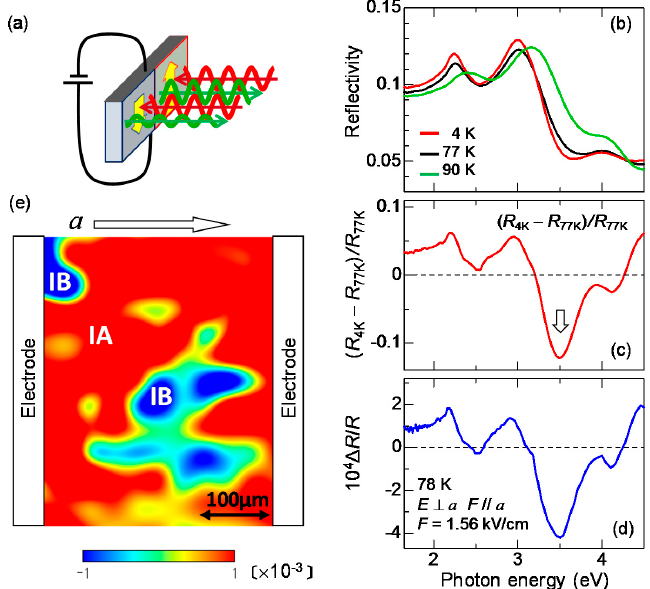
Figure 7. Polarization-domain imaging by electro-reflectance (ER) spectroscopy in TTF-CA [61]. ( a ) Schematic of a polarization-domain imaging method; ( b ) Polarized reflectivity spectra with E ⊥ a at 90 K (the neutral phase) and at 77 K and 4 K (the ionic phase); ( c ) A differential reflectivity spectrum between 4 K and 77 K, [ R I (4 K) − R I (77 K)]/ R I (77 K); ( d ) A spectrum of reflectivity changes Δ R / R induced by external electric fields F (// a ) with an amplitude of 1.56 kV/cm; ( e ) A polarization domain image shown as a contour map of electric-field-induced reflectivity changes Δ R / R at the photon energy indicated by the arrow in ( c ). Red regions (IA) and blue regions (IB) have opposite directions of polarizations.